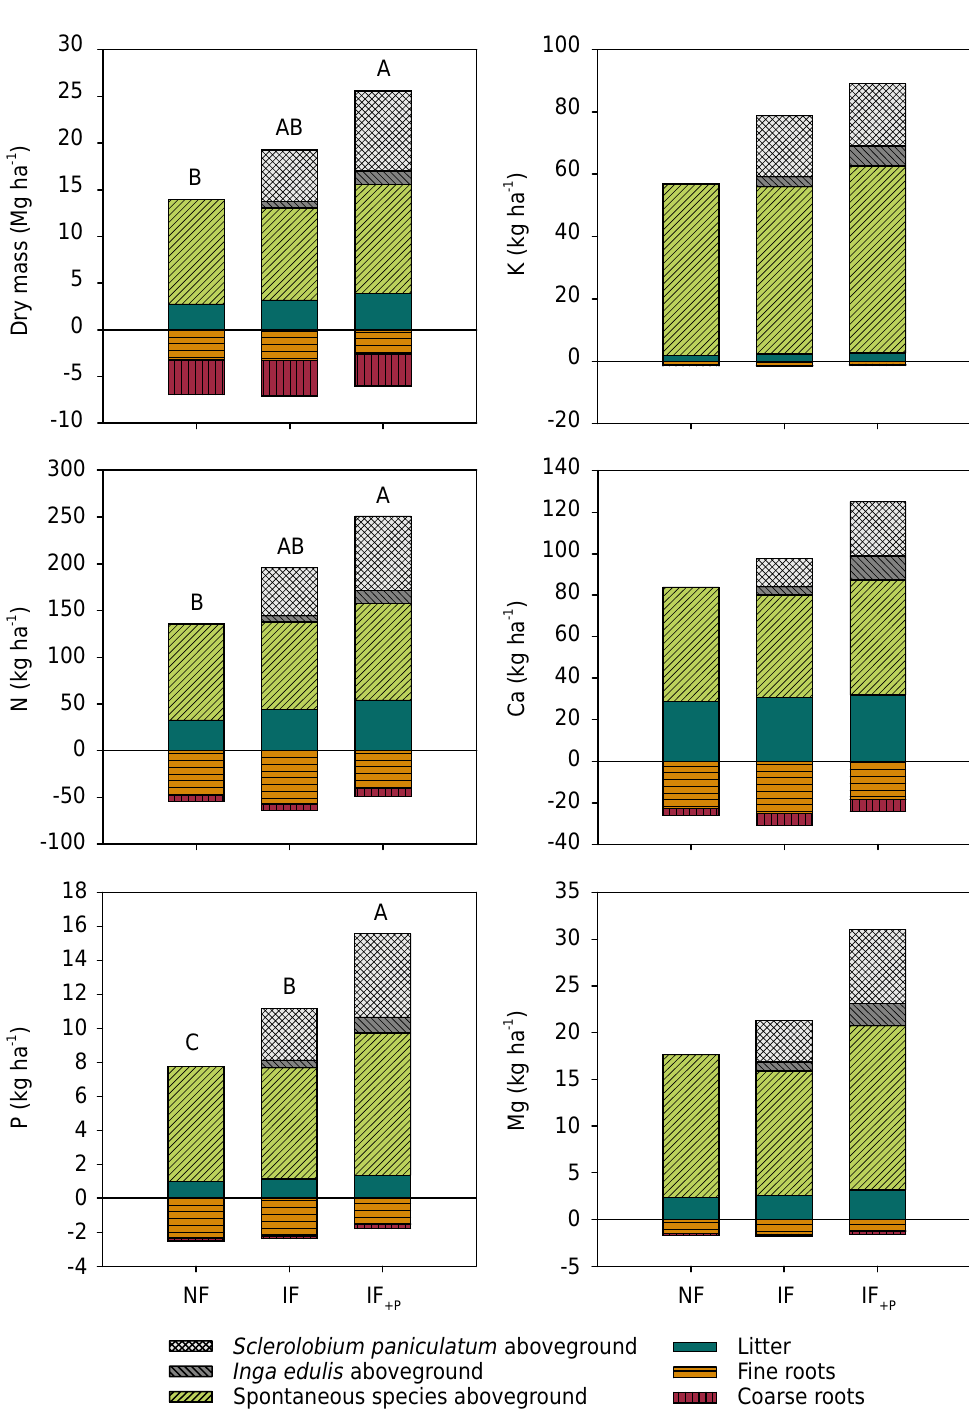
Sclerolobium paniculatum aboveground Inga edulis Spontaneous species aboveground Figure 1. Biomass and nutrient stocks in the aboveground, litter, and root compartments after 23 months of natural fallow (NF), improved fallow (IF), and improved fallow with P fertilization (IF +P ) in Marapanim, eastern Amazonia. Different letters indicate that treatment means differ significantly at a significance level of 5 % (Tukey’s test).